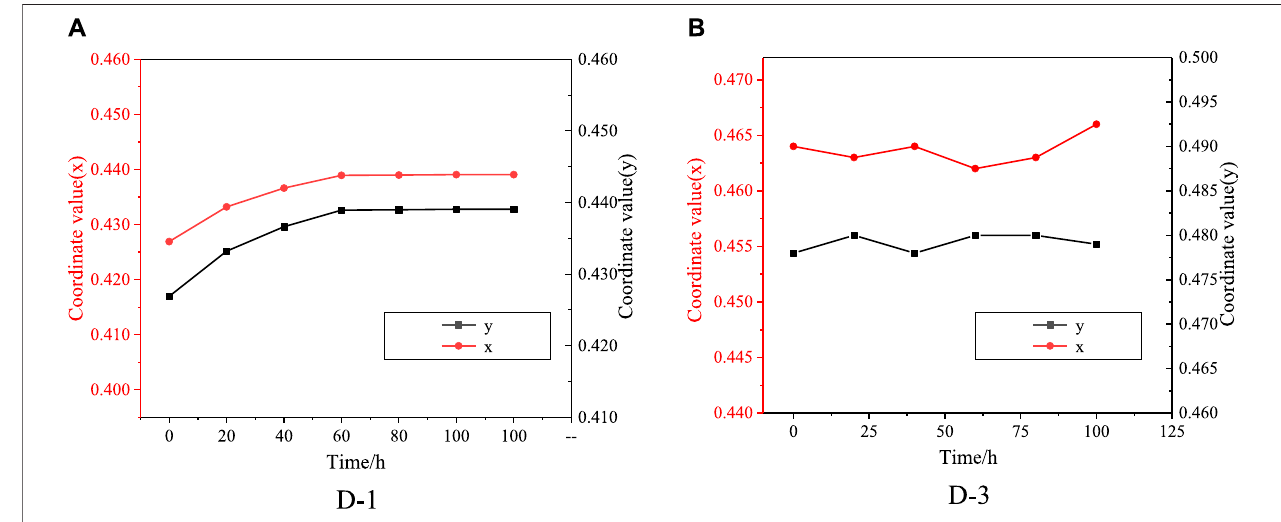
FIGURE 7 | Variation of color coordinates (x, y) of oils in CIE1931 color space (Irradiation condition: 0.55 W/m 2 (340 nm); Temperature 45 ° C); (A) : D-1; (B) : D-3.